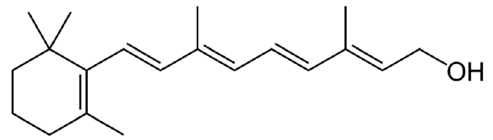
Figure 3. Chemical structure of vitamin A, retinol.